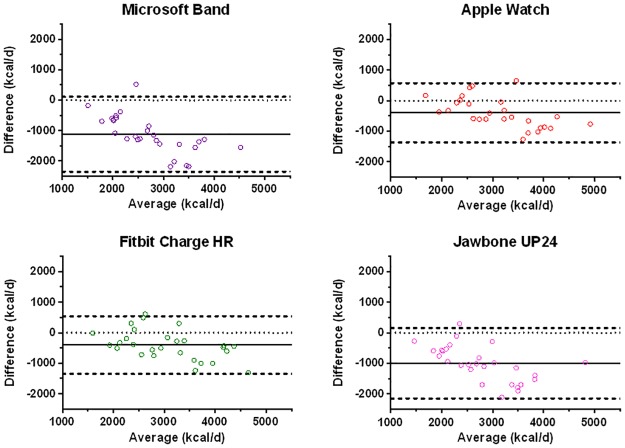
Bland-Altman plots for daily energy expenditure.Bland-Altman plots depicting bias and 95% limits of agreement of 24 hr energy expenditure for a range of commercial activity trackers relative to the criterion individually calibrated Actiheart device. Bias represents (predicted expenditure—criterion expenditure). The solid line represents absolute bias, the dashed lines the upper and lower 95% limits of agreement and the dotted line represents perfect agreement.